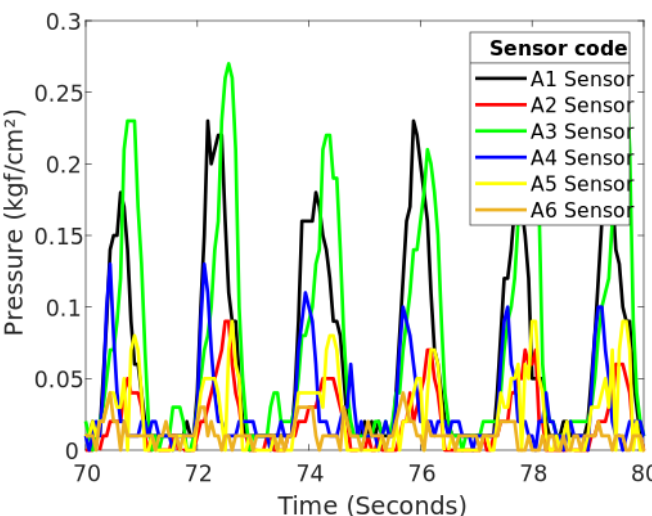
Figure 19. Pressure generated during the second minute of the gait for